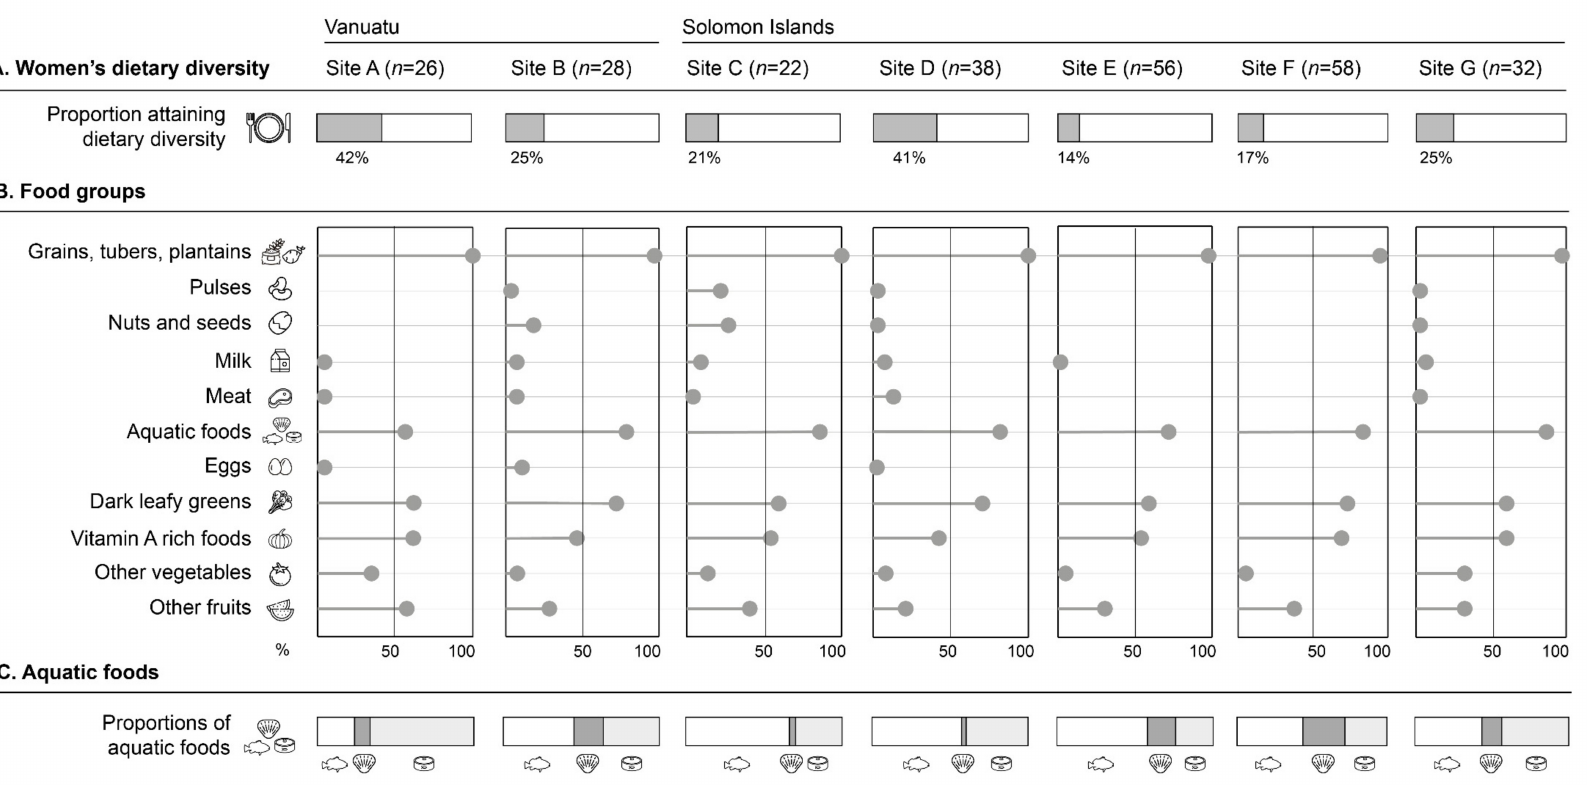
Figure 2. Village-level consumption based on 24-h recall of women of reproductive age ( n = 260) [25]. ( A) . Proportion of women attaining minimum dietary diversity (five or more food groups); ( B ) . Frequency of food group consumption in 24-h recall; ( C ). Proportion of three categories of aquatic foods (finfish, invertebrates, canned tuna) reported in 24-h recall. Foods are grouped based on their nutritional content as defined in the MDD-W index method [62]. The group ‘Vitamin A rich foods’ includes other Vitamin A rich fruit and vegetables not included in other groups. ‘Aquatic foods’ includes animal sourced aquatic foods only. Together, meat and aquatic foods (separated for this figure) contribute as an aggregate score out of one in calculating total diet diversity